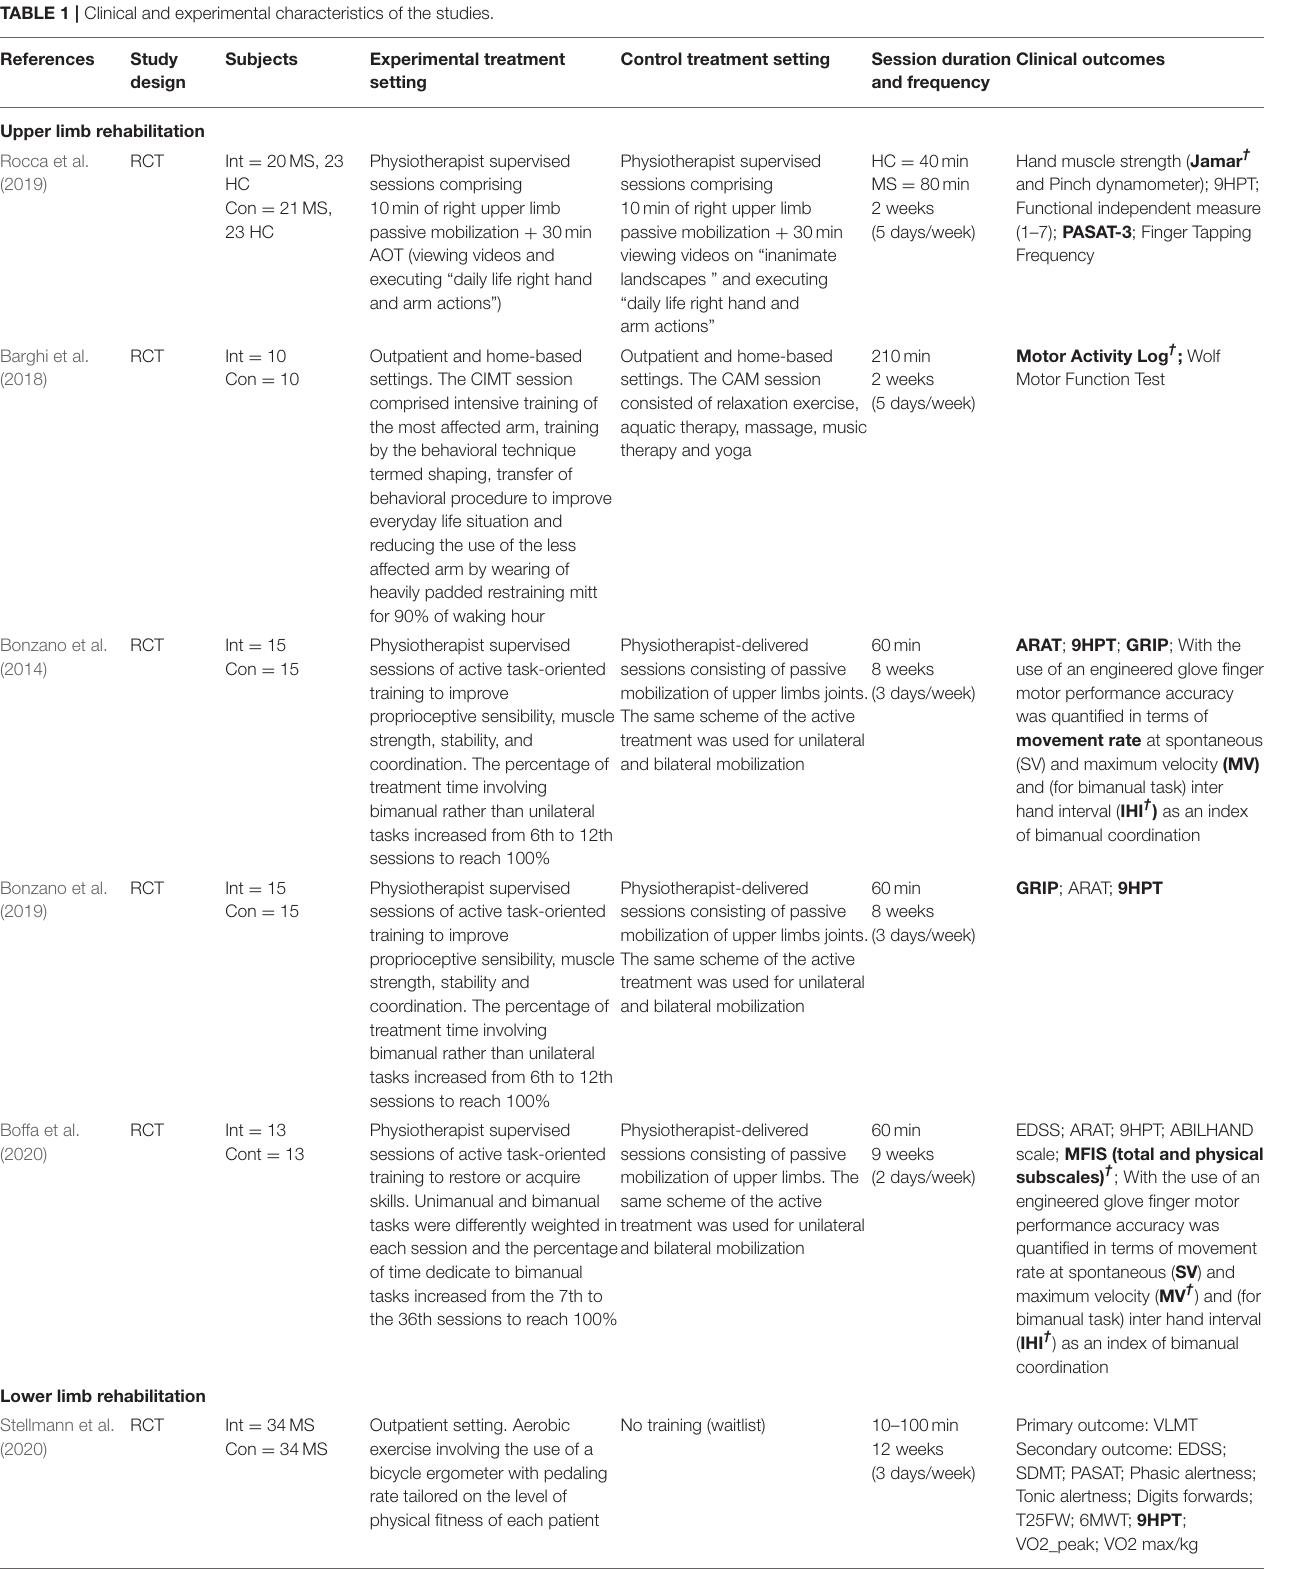
TABLE 1 | Clinical and experimental characteristics of the